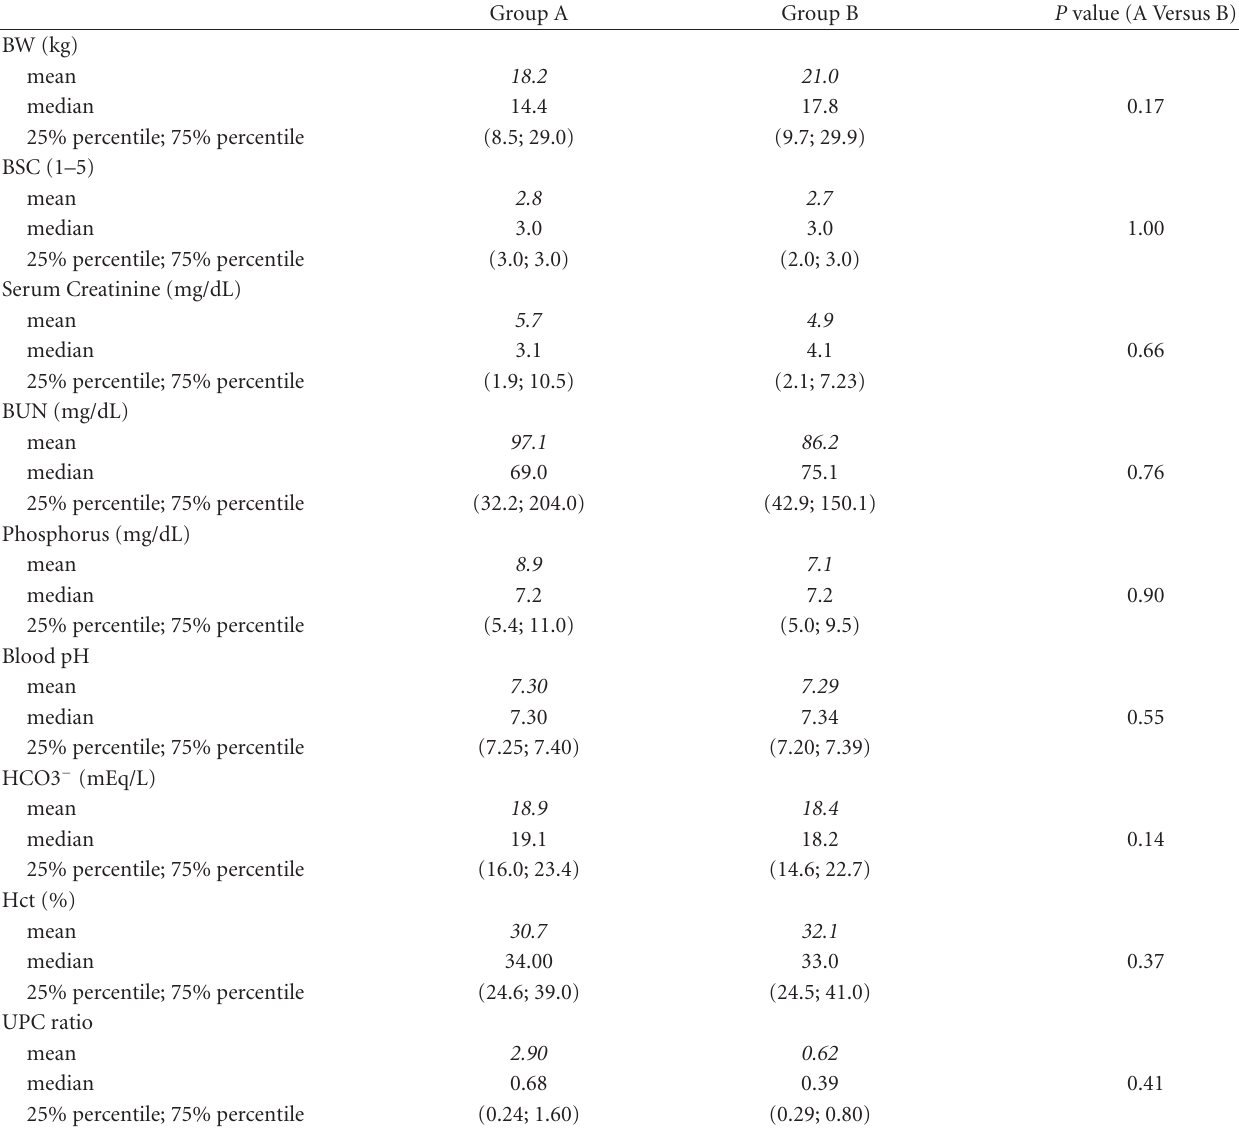
Table 2: Mean, median, and 25% and 75% for BW and BCS, hematocrit, serum creatinine, BUN, phosphate, blood pH, bicarbonate, and UPC ratio, for Group A and B at time of randomization. Di ff erences between groups are depicted by P value (statistically significant P < 0 .